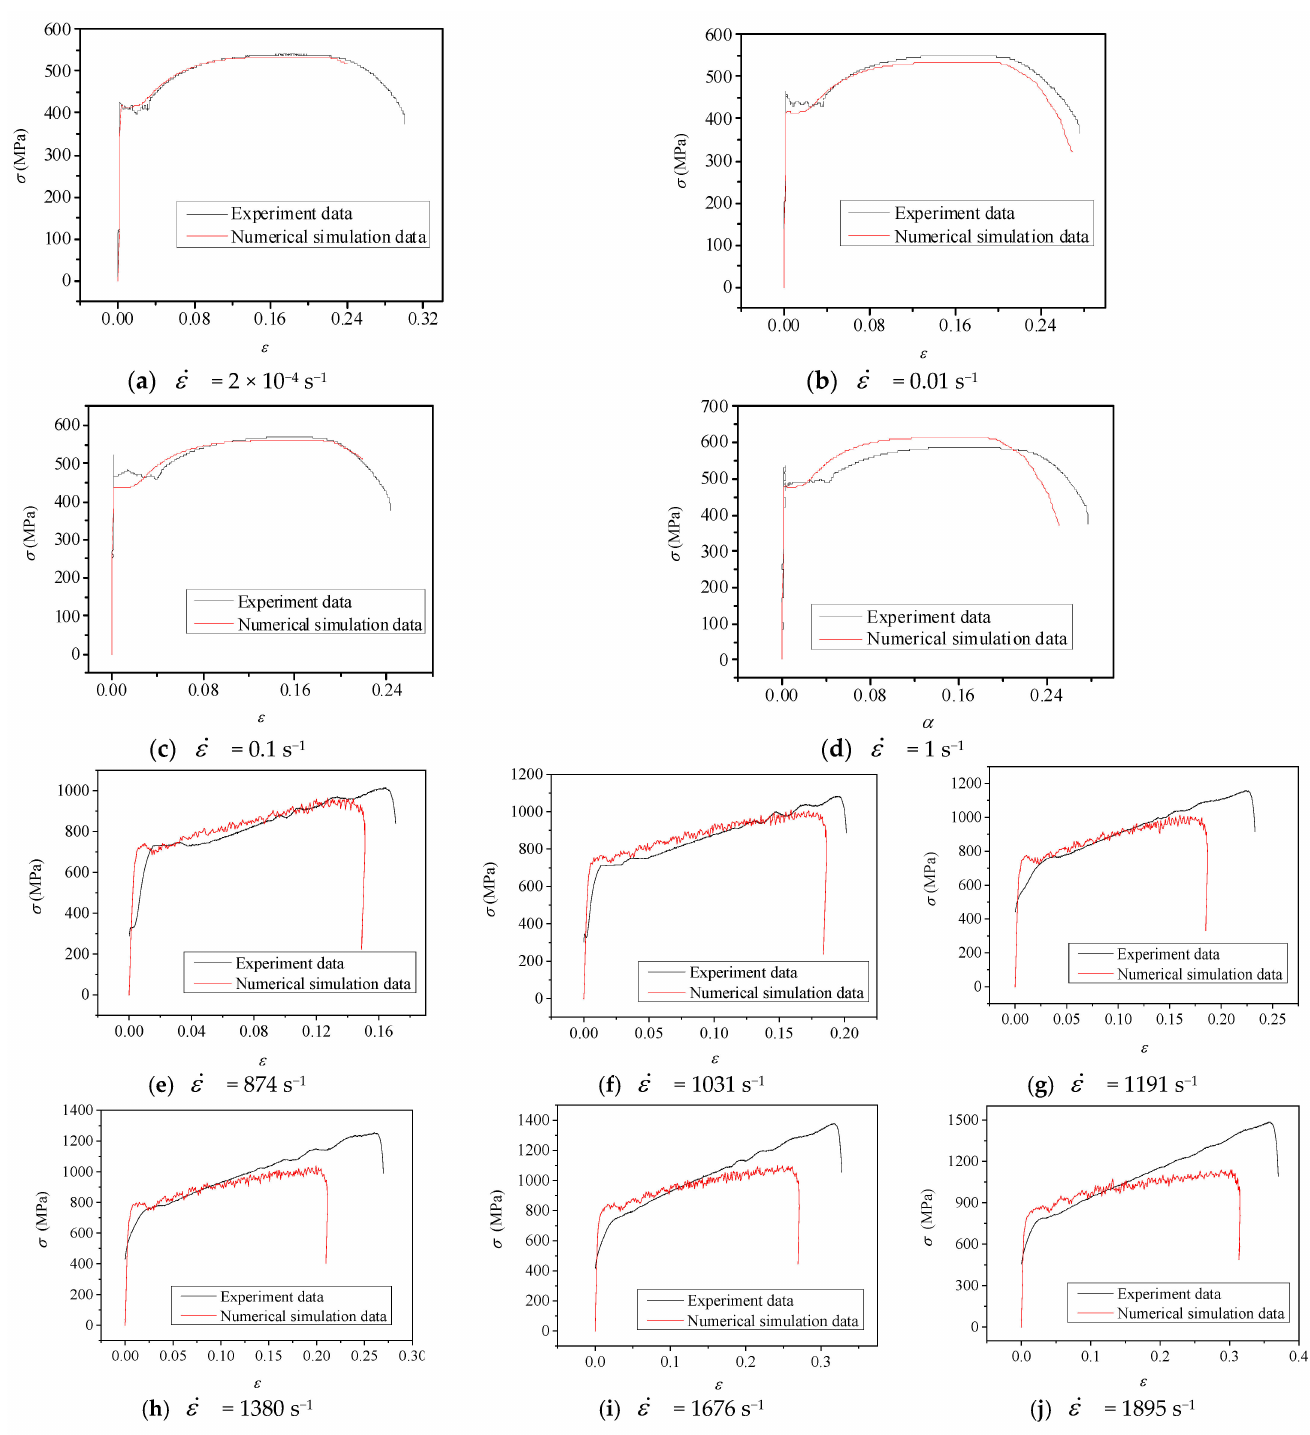
Figure 20. Comparison of numerical and test results at − 20 ◦ C with high strain